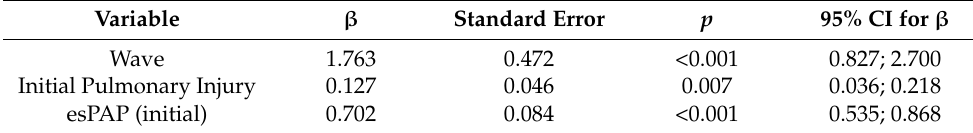
Figure 2. Evolution of esPAP, FAC, RV-GLS, and PCFS scale in patients with PH and borderline values who suffered from COVID-19 during the first, second, and third wave. Legend: esPAP—echocardiographically estimated systolic pressure in the pulmonary artery; FAC—fractional area change; RV-GLS—right ventricular global longitudinal strain; PCFS—Post-COVID-19 Functional Status; p -statistical significance of Friedman test. Table 4. Multivariate linear regression predicting the esPAP levels at 6